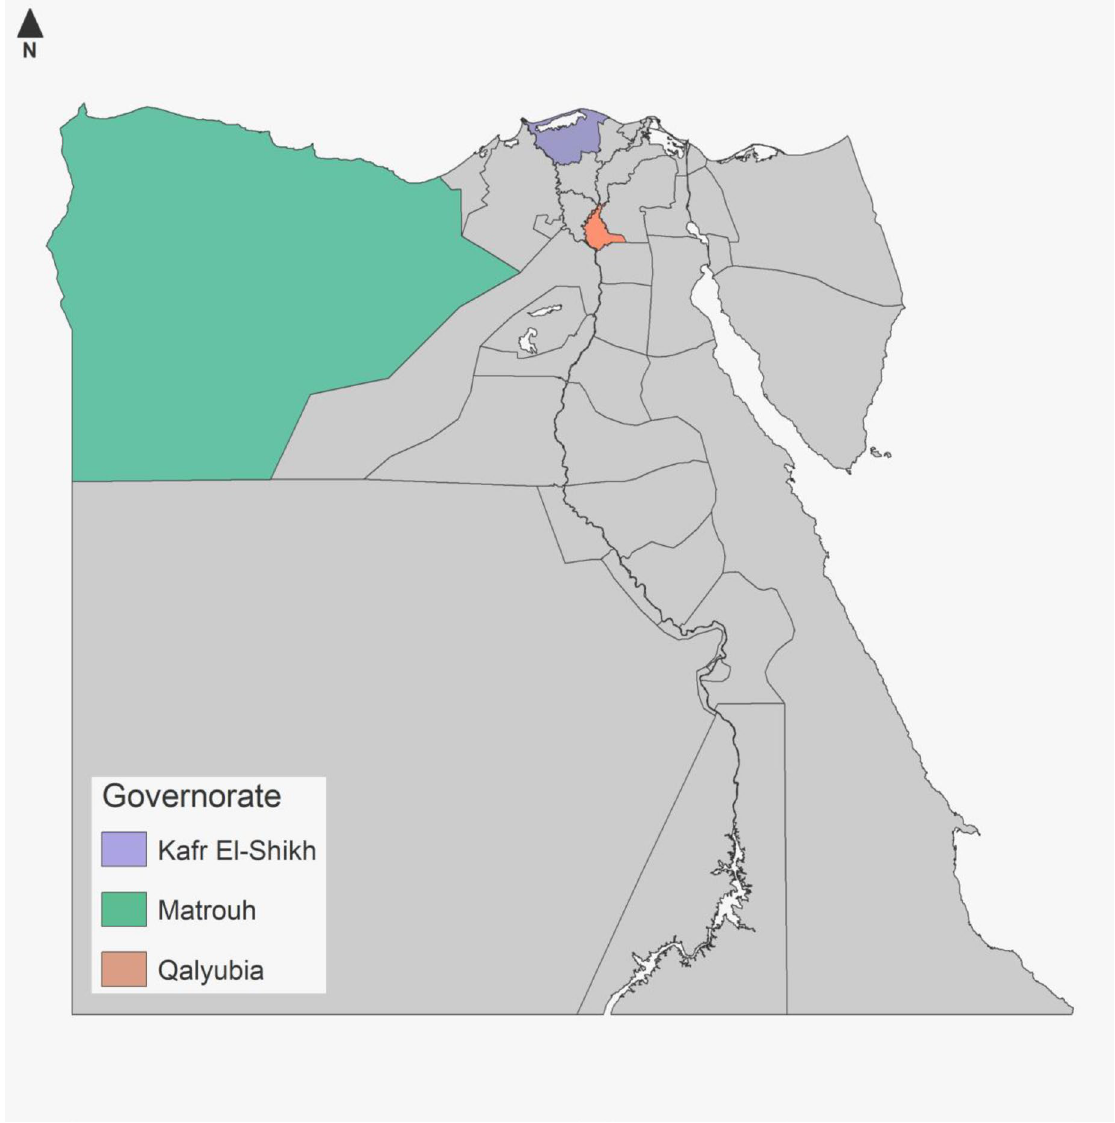
Figure 1. Map of Egypt showing the three sampled